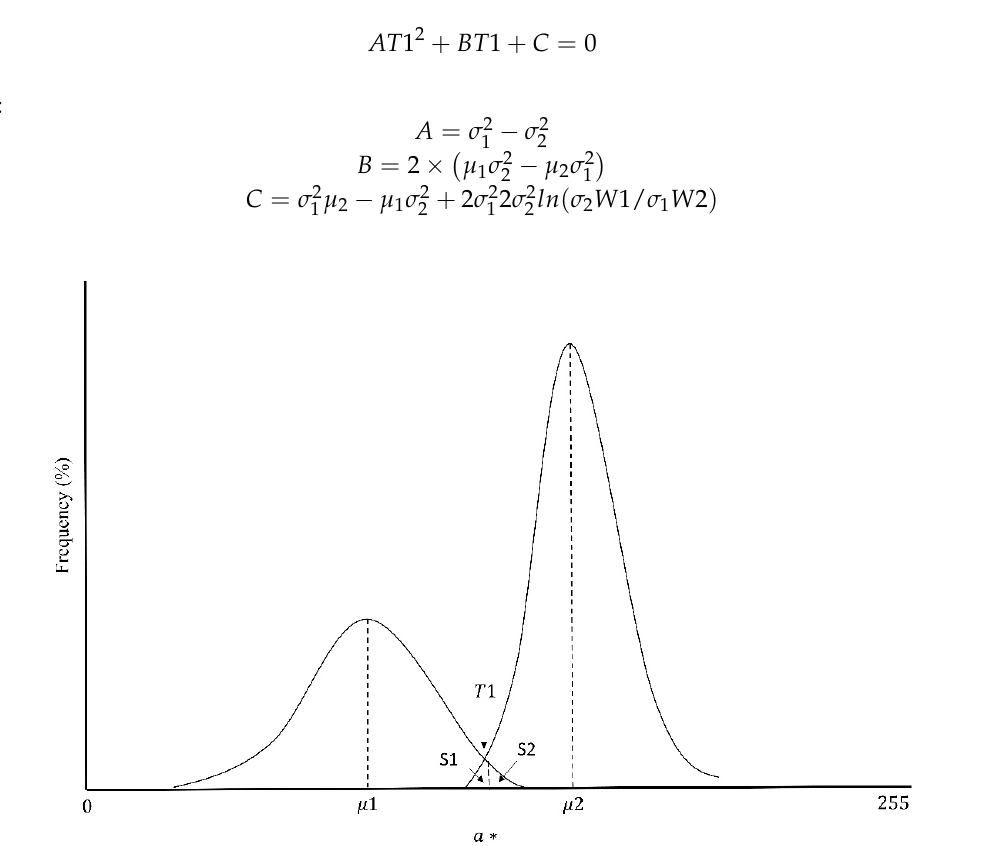
Figure 5. Identification of the optimal T 1 threshold in a bimodal distribution